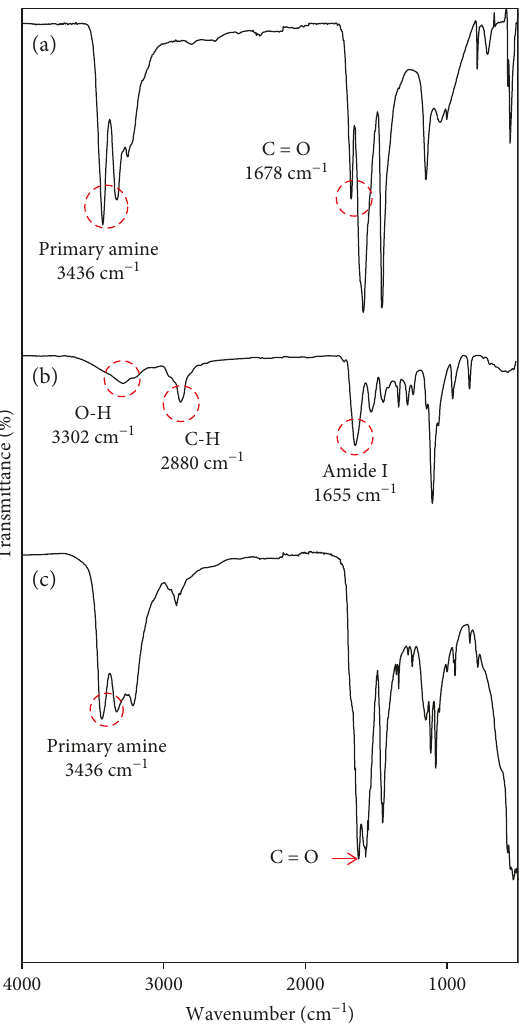
Figure 7: Fourier transform infrared (FTIR) spectra of (a) urea, (b) wheat-gluten proteins soluble in ethanol (WGPSE) microparticles without urea and (c) urea-loaded WGPSE